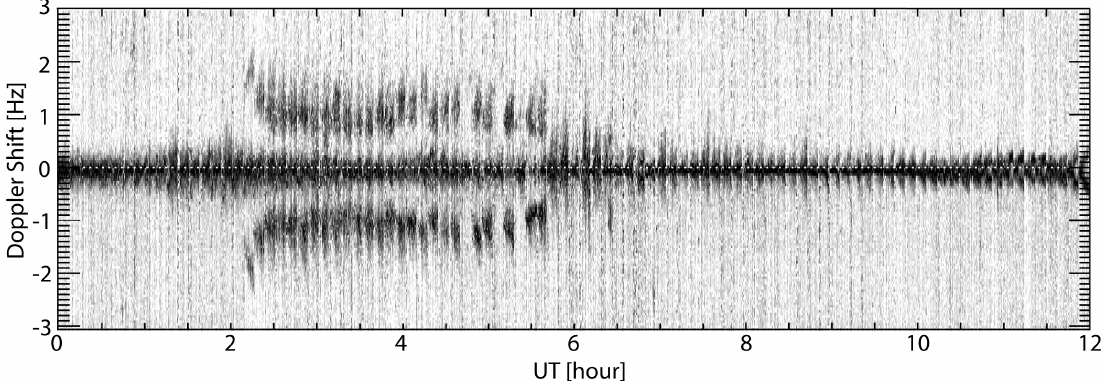
Fig. 6. E-region drift dynamic spectra recorded from 00:00 to 12:00 UT on 16 December 1996. Only the amplitude spectra recorded on one antenna and at around 110-km group range for all frequencies per CIT subset are displayed. Each single spectrum is normalized to its maximum amplitude. The dynamic gray-scale ranges from the most probable to the maximum amplitudes to achieve optimum signal-to-noise contrast. The overall Doppler range spans 6.25Hz. The sounding frequencies range from 1.5 to 2.65MHz per single measurement. The group ranges never exceed 150km over the entire time interval and truly correspond to E-region Doppler drift measurements. Side-peaks appearing between 02:00 and 06:00 UT are spectral signatures observed during intense SEC/lacuna